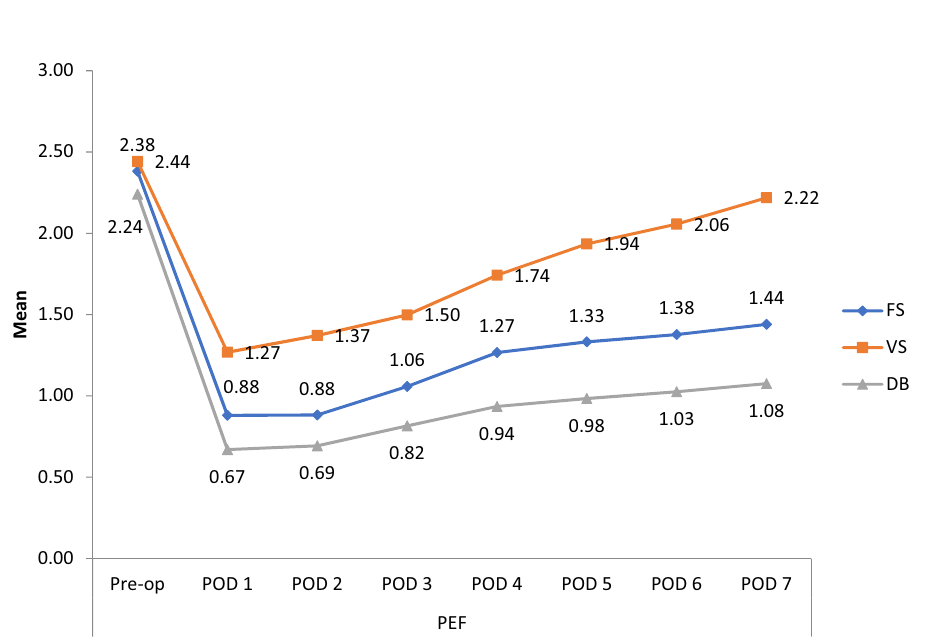
Figure 5. Comparison of peak expiratory flow rate (PEFR) before and after coronary artery bypass graft surgery between three groups.